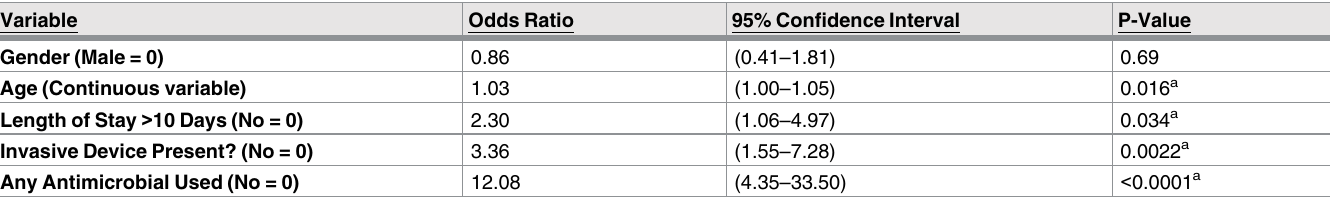
Table 2. Logistic regression analysis of CRKP in point prevalence